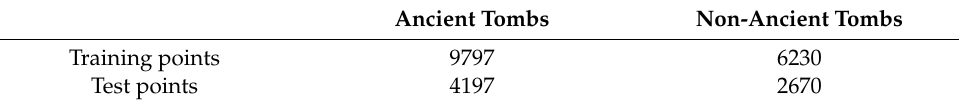
Table 4. Number of samples of ancient tombs under forest and non-ancient tombs under forest.